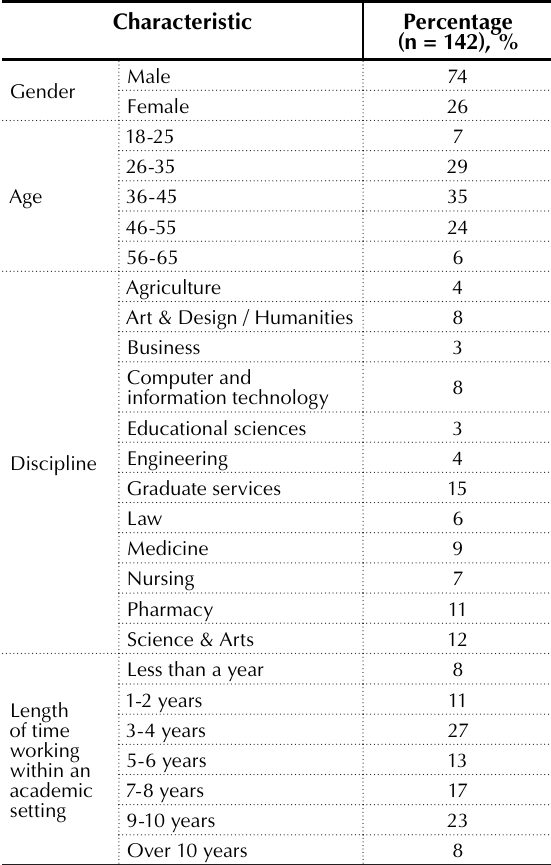
Table 2. Respondents’ demographic profile Characteristic